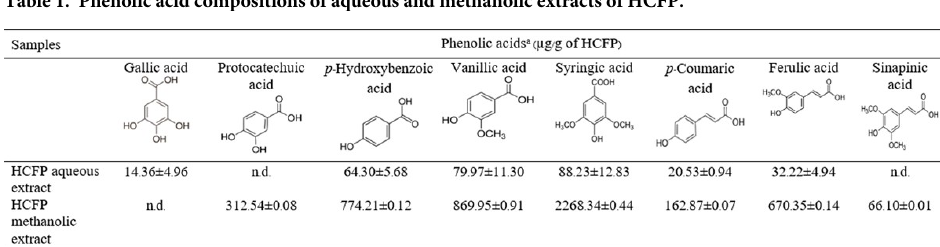
Table 1. Phenolic acid compositions of aqueous and methanolic extracts of HCFP.